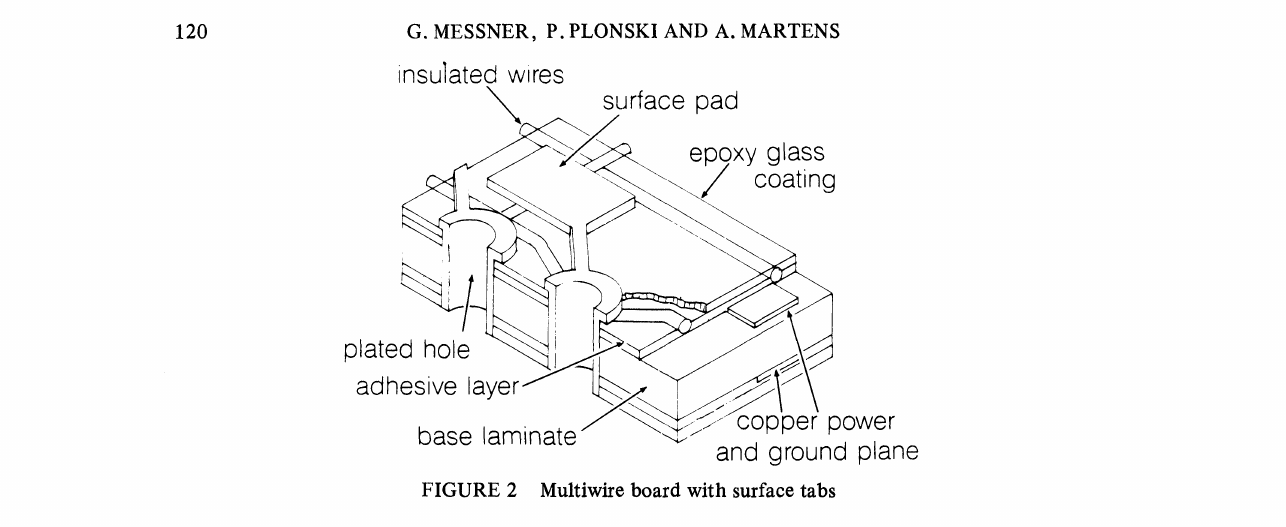
FIGURE 2 Multiwire board with surface